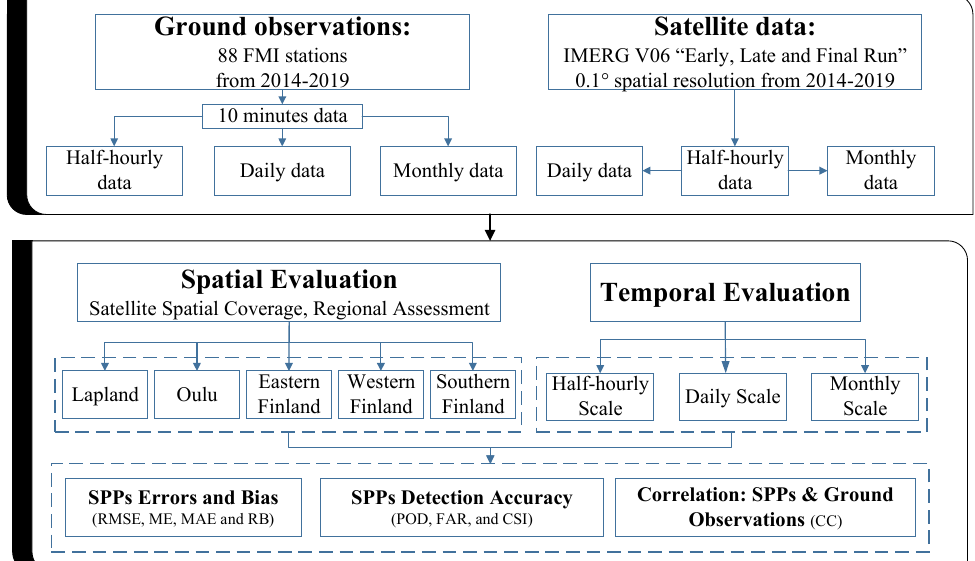
Figure 5. IMERG SPPs evaluation process.